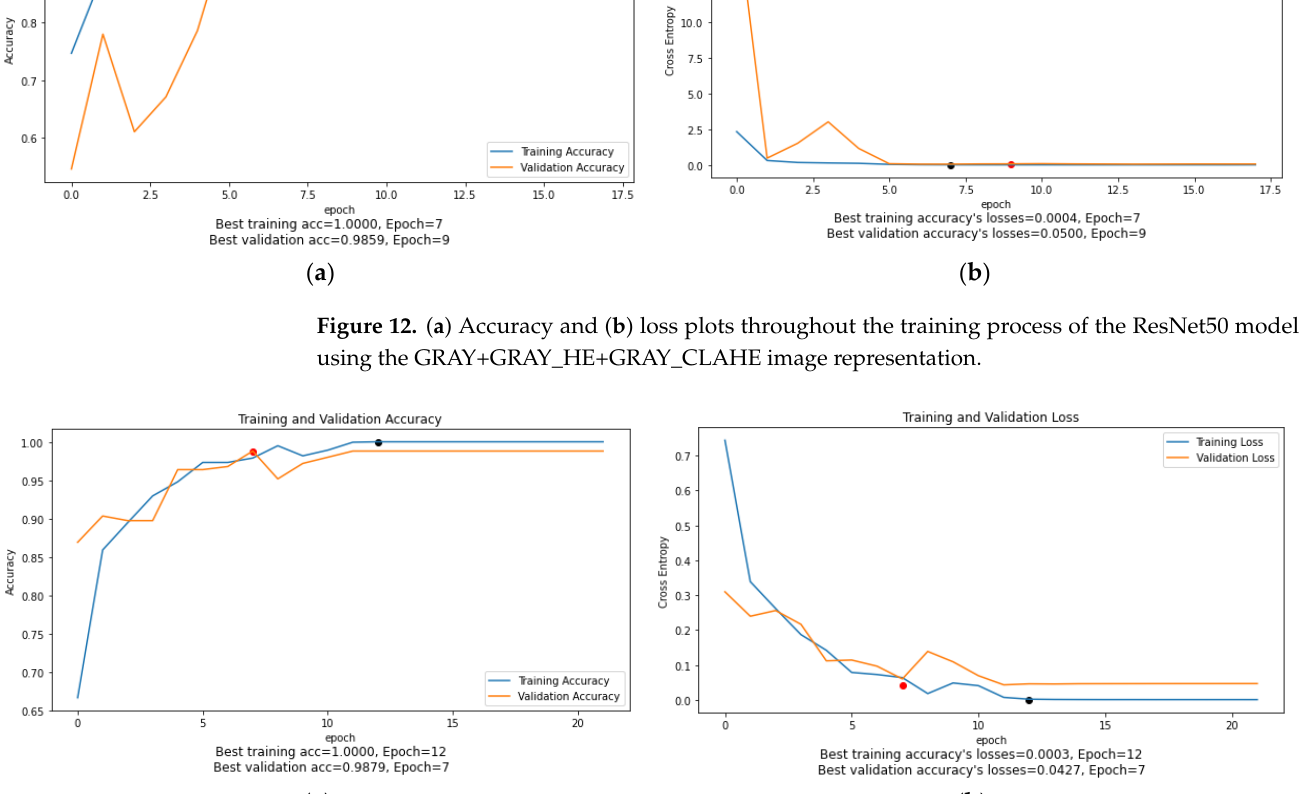
Figure 13. ( a ) Accuracy and ( b ) loss plots throughout the training process of the VGG16 model using the GRAY+GRAY_HE+GRAY_CLAHE image representation.